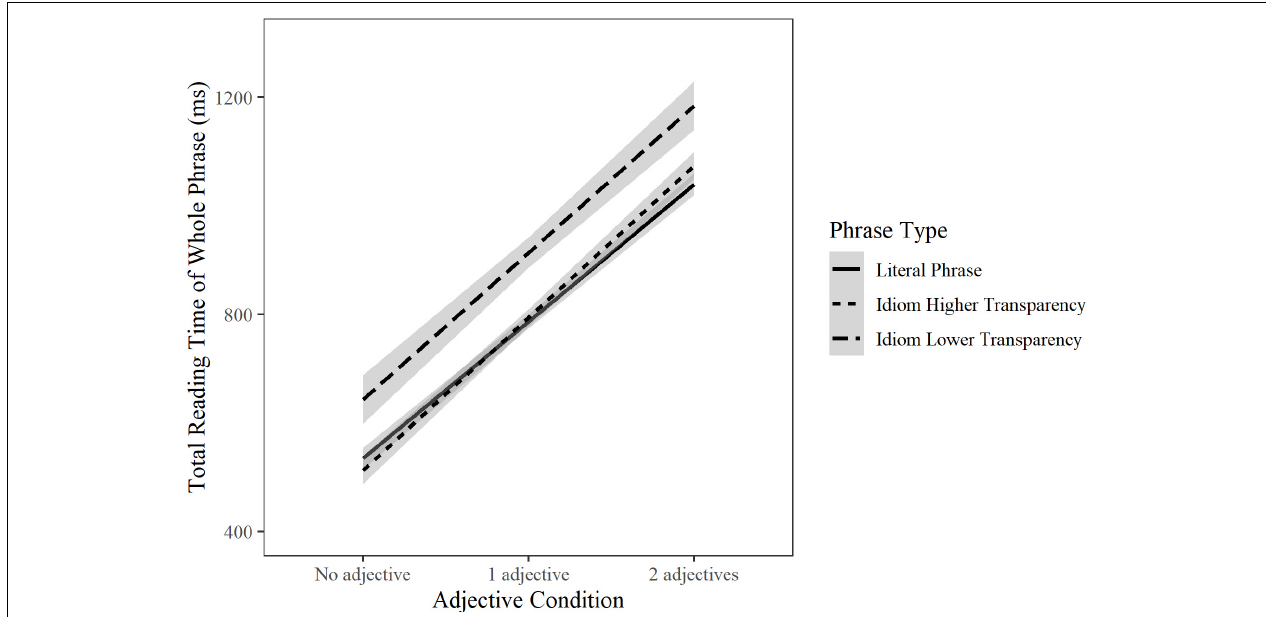
FIGURE 1 | The total reading time in ms of high versus low transparent idioms and matched literal phrases. Highly transparent idioms had a transparency score < 3.